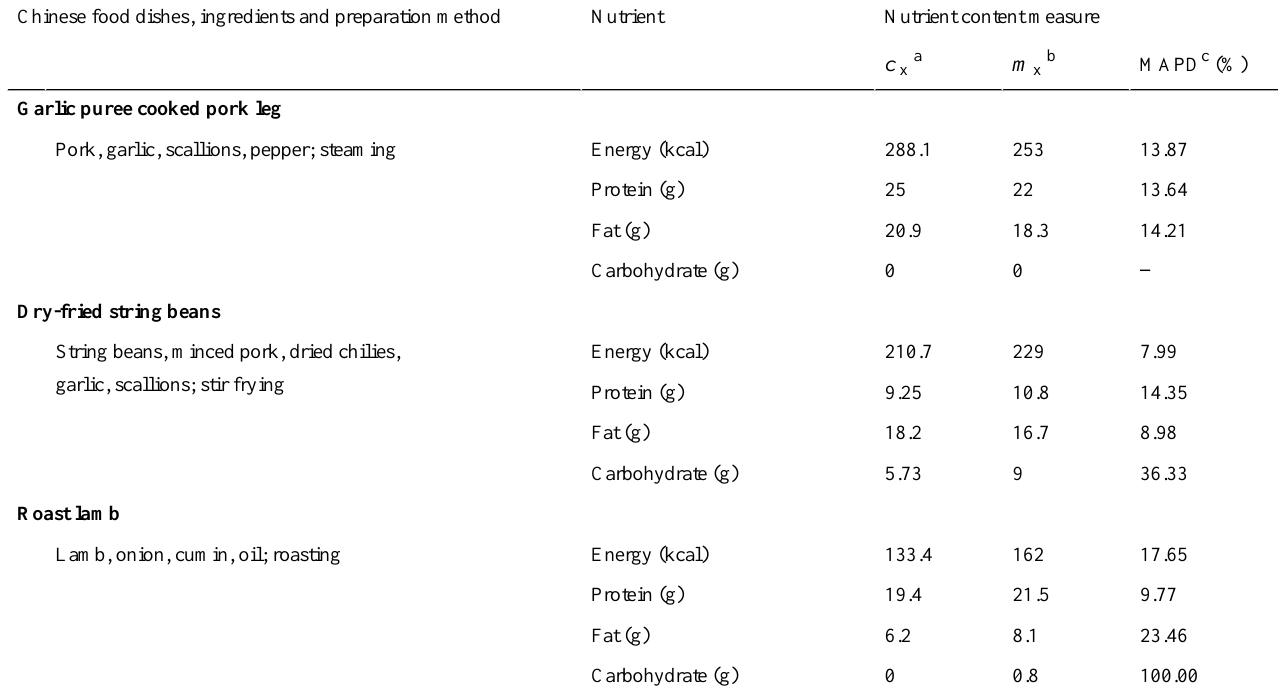
Table 1. Nutrient calculation results compared with chemical measurements.